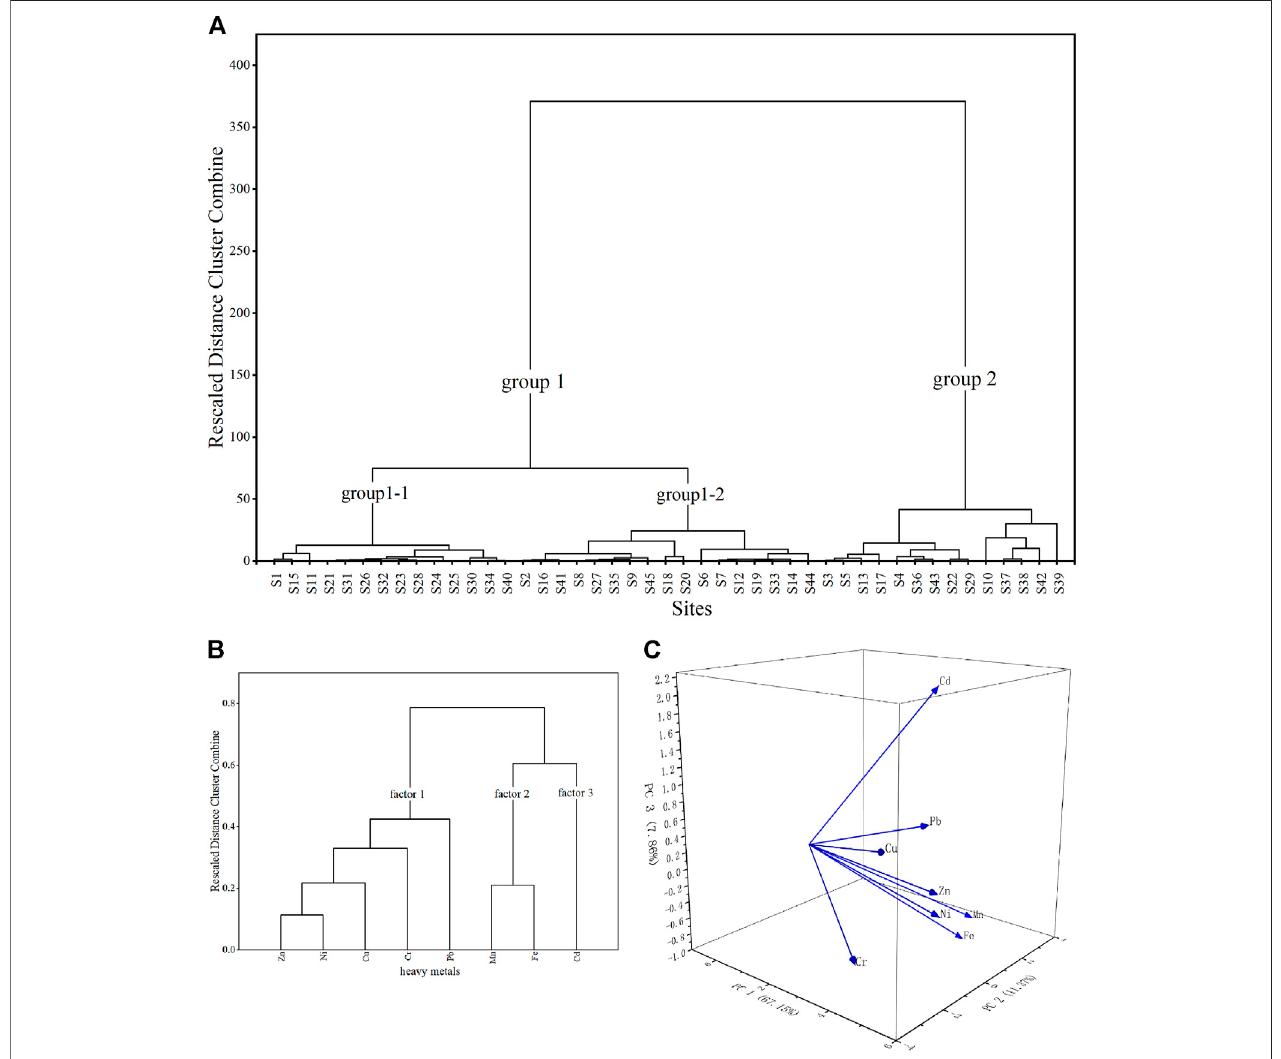
FIGURE 2 | (A – B) Cluster diagram of sampling sites and heavy sites and heavy metal elements obtained using Ward ’ s method and Squared Euclidean distance matrix. (A) Sampling sites. (B) Heavy metal elements. (C) Principal component analysis of different metals.